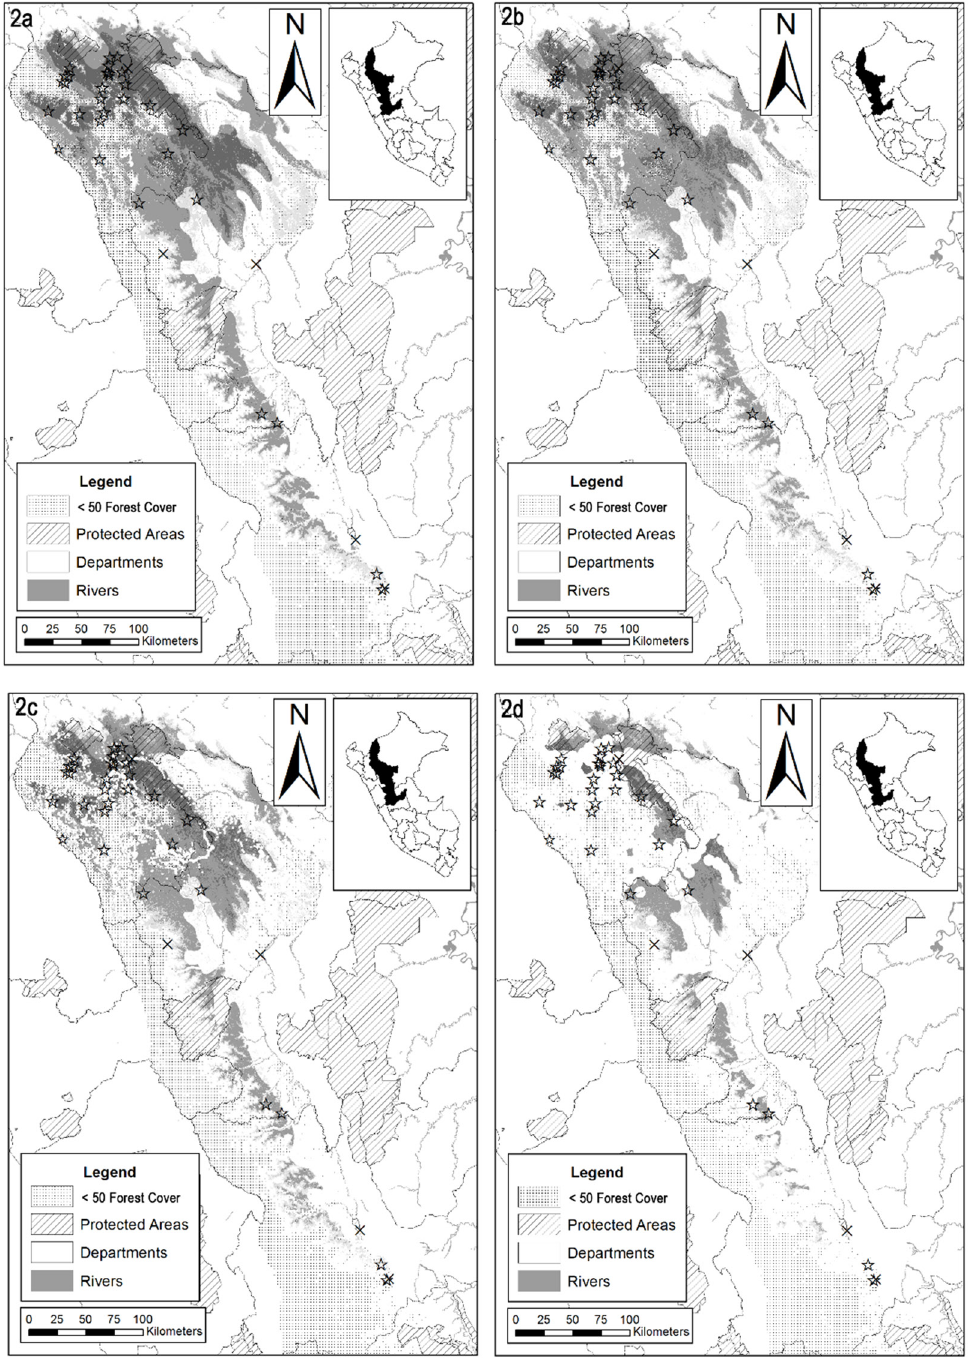
Figure 2. Predicted habitat for A. miconax based on maximum entropy ecological niche modelling: 2a - original extent of A. miconax habitat; 2b - estimated current extent of A. miconax habitat based on deforestation estimates from the Global Land Cover 2009 assessment; 2c - estimated current extent of A. miconax habitat including 1 km buffers around human settlements and highways; 2d - estimated current extent of A. miconax habitat including 5km buffers around human settlements and